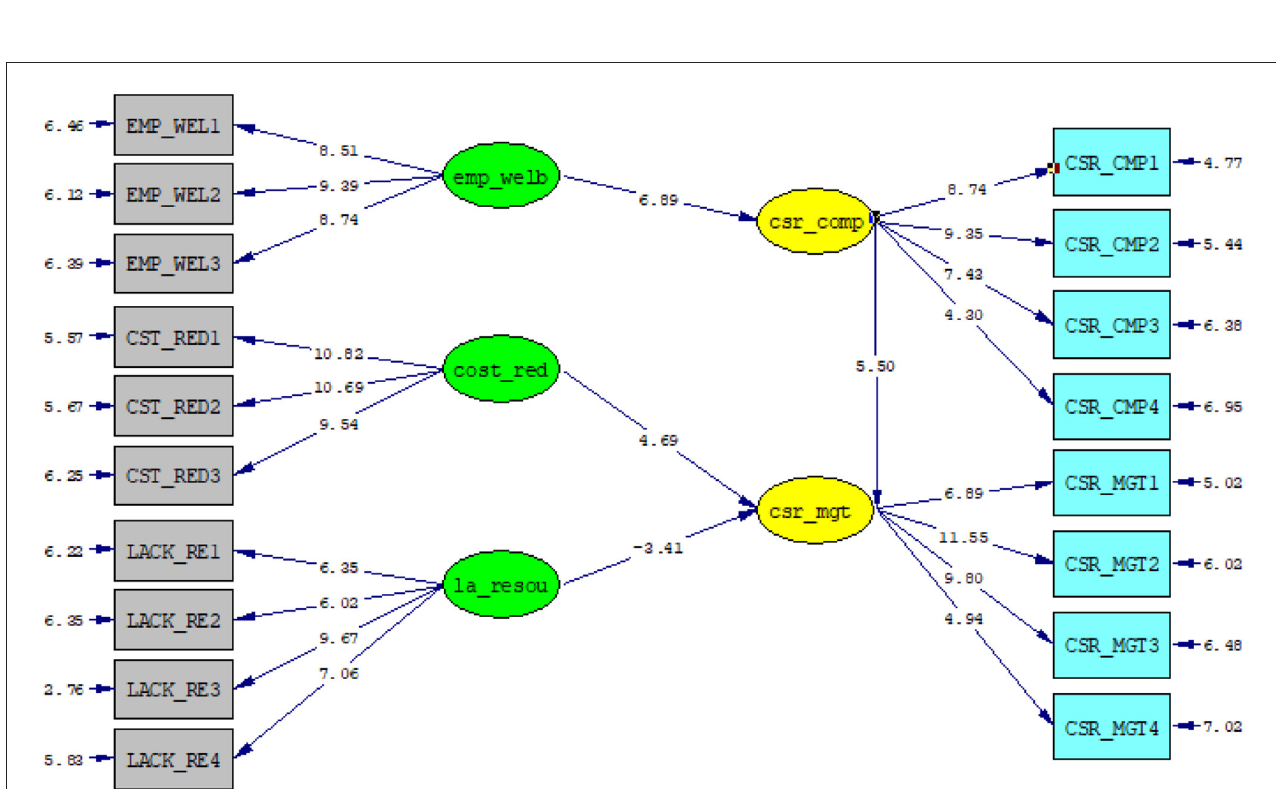
FIGURE4 Bootstrapping